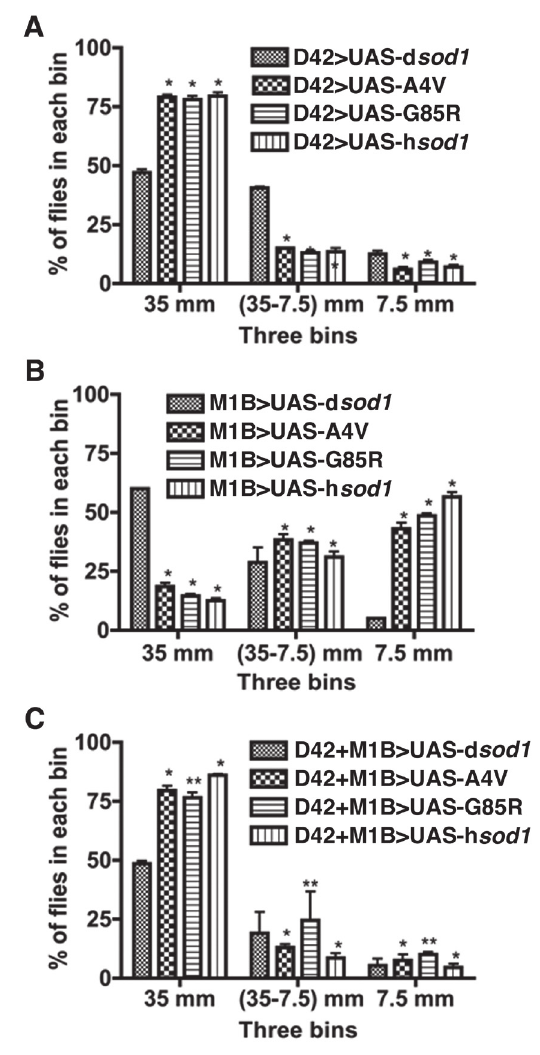
Figure 1. Climbing behavior of 60 day-old flies. Healthy looking 60 day-old male flies were selected for this assay. Ten flies were placed in a 100 ml glass cylinder. Following a brief and gentle tapping, the distribution of flies was then counted in 3 bins at different heights (above or at 35 mm height, between 7.5 mm and 35 mm, and 7.5 mm or lower). Climbing pattern of flies expressing SOD1 in motoneurons ( A ), glial cells ( B ), and co-expressing SOD1 in both motoneurons and glial cells ( C ) are shown. Flies expressing human SOD1 Figure 2. Survival curve of wild type ( Canton S ) Drosophila under